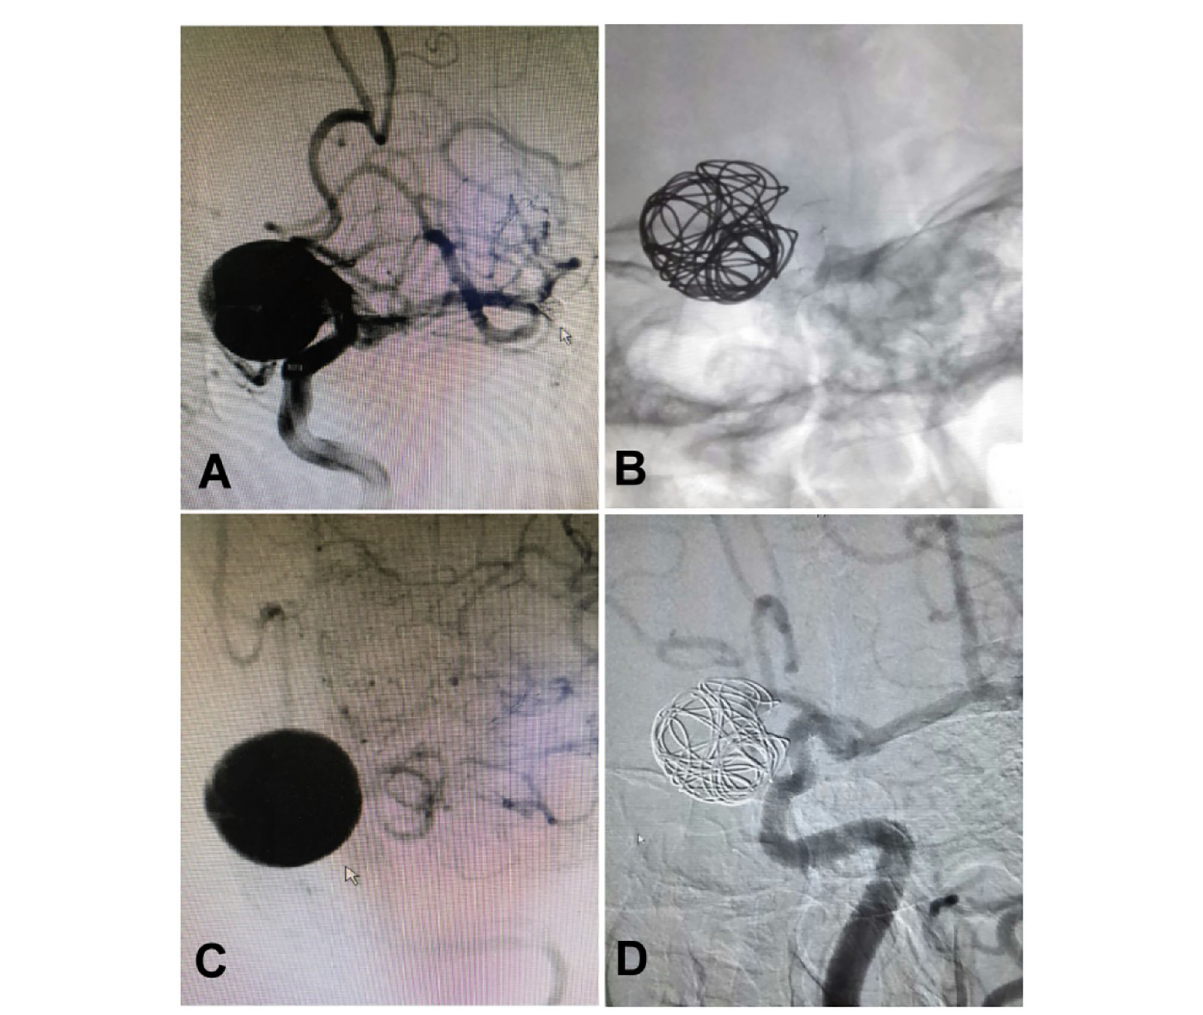
FIGURE4 A woman in her 40’s with intermittent headache for half a year was found to have an aneurysm measuring 15 × 15mm at the ophthalmic segment of the internal carotid artery treated with deployment of a Pipeline embolization device and adjunctive coiling. (A) The aneurysm was found at the ophthalmic segment. (B) A 4.0 × 25mm Pipeline embolization device was deployed before adjunctive coiling. (C) The aneurysm was shown at the end of the embolization. (D) One year after embolization, the aneurysm was completely